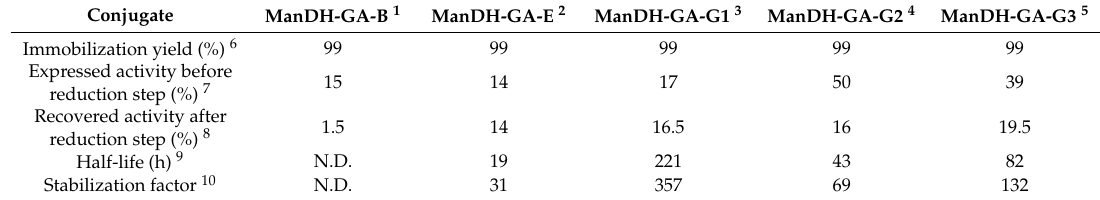
Table 3. Immobilization parameters of ( R )-mandelate dehydrogenase (ManDH)-GA preparations.